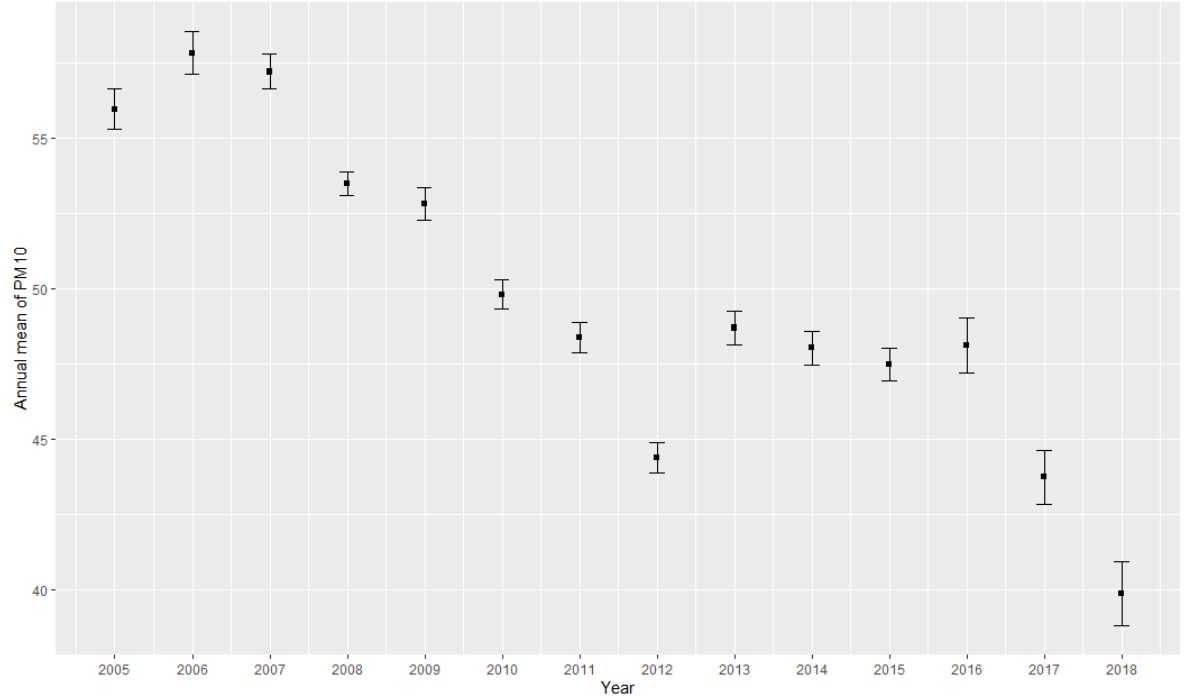
Figure 1. Annual mean PM 10 concentration during the study period (2005–2018).